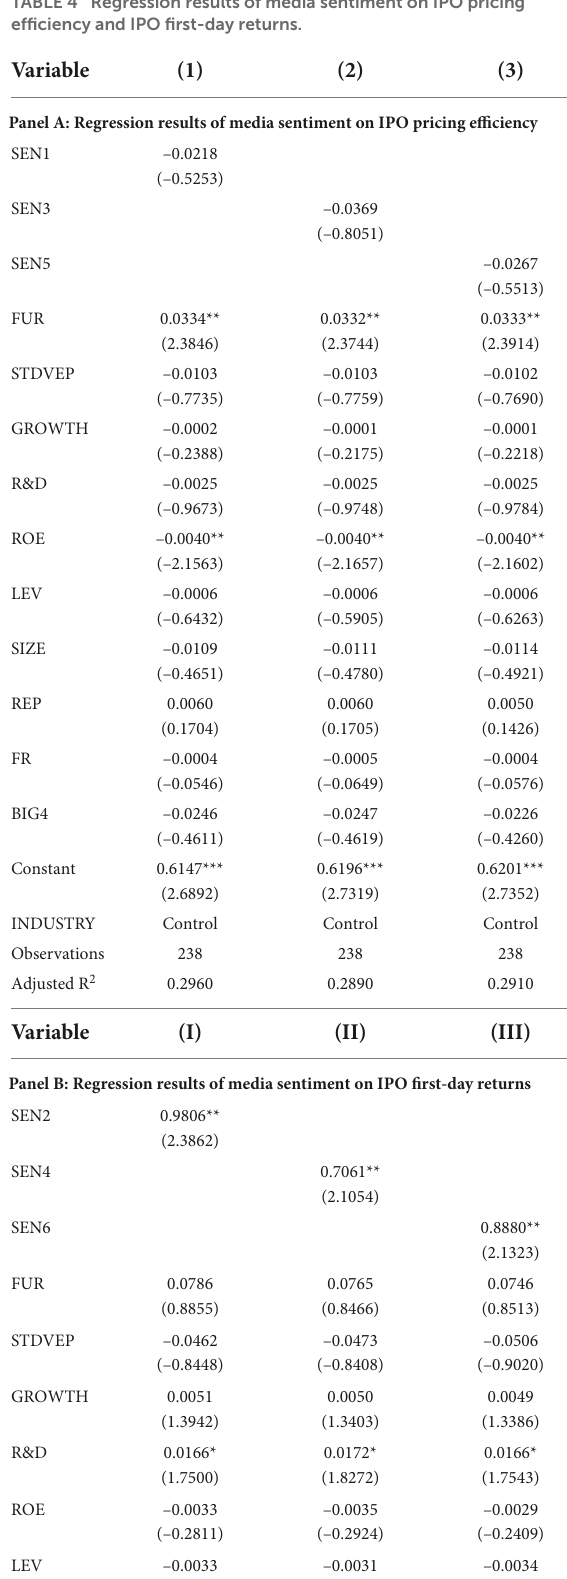
TABLE 2 Descriptive statistics.